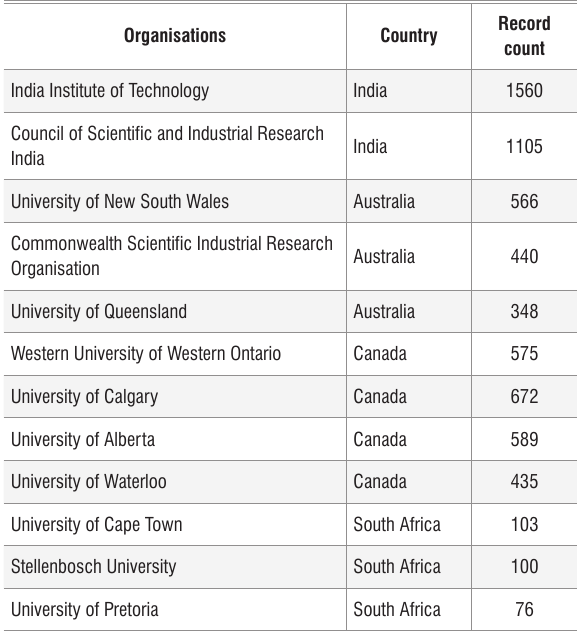
Countries collaborating with South Africa in Energy and